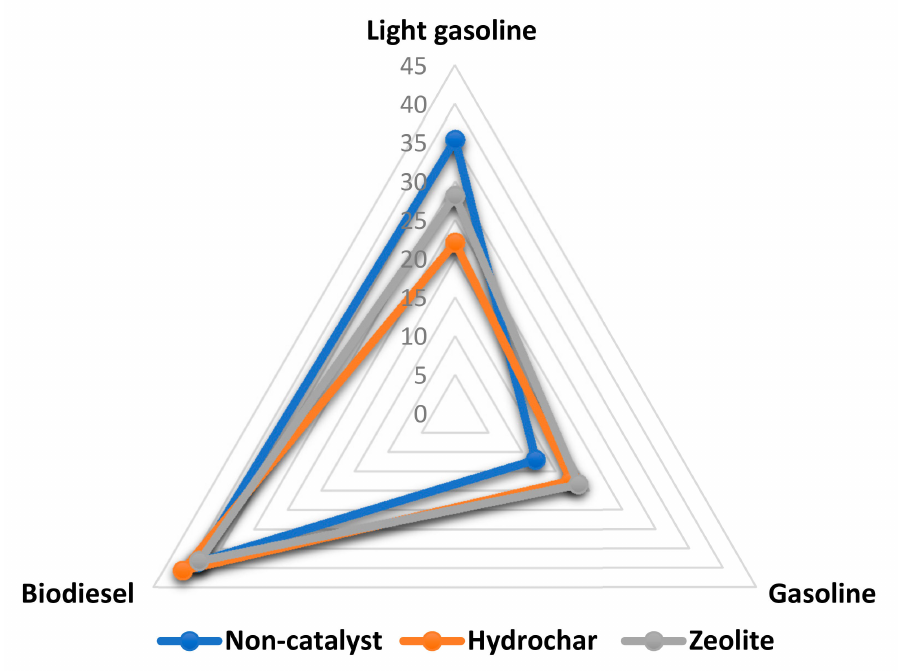
Figure 4. Comparison of selected petroleum products in terms of selectivity